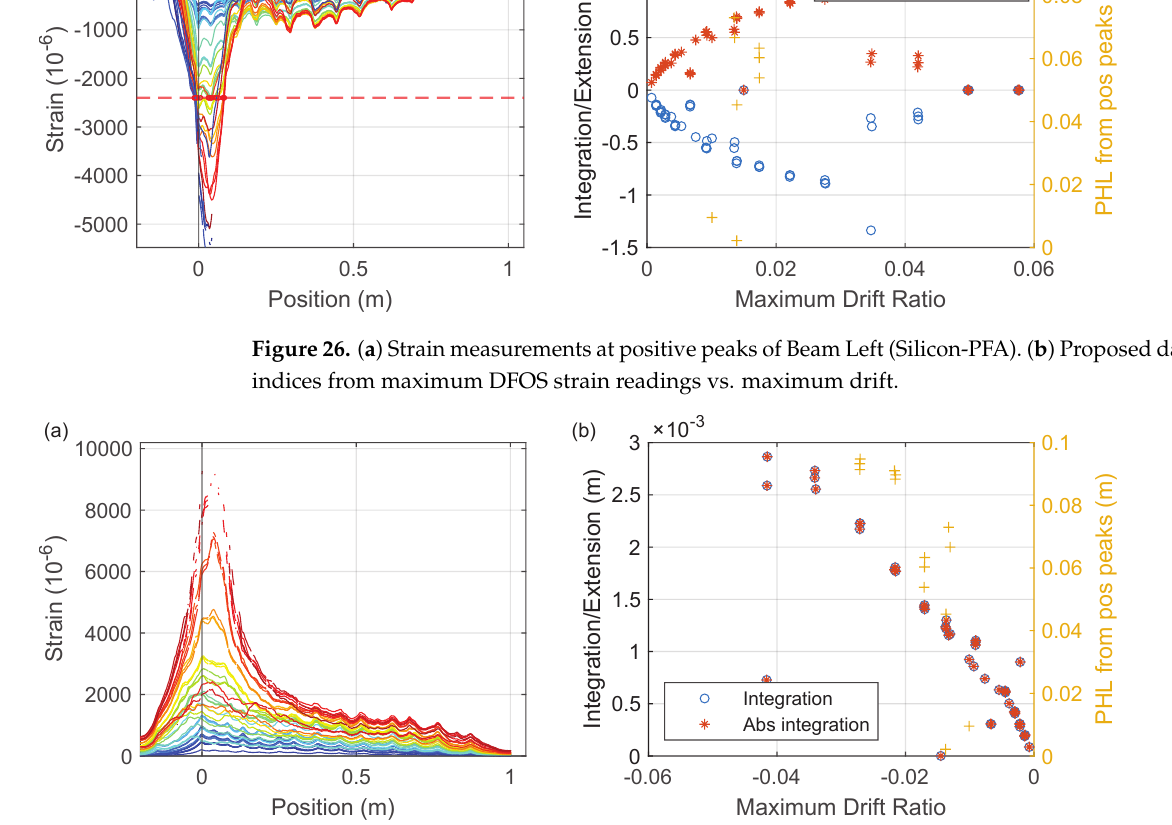
Figure 27. ( a ) Strain measurements at negative peaks of Beam Left (Silicon-PFA). ( b ) Proposed damage indices from maximum DFOS strain readings vs. maximum